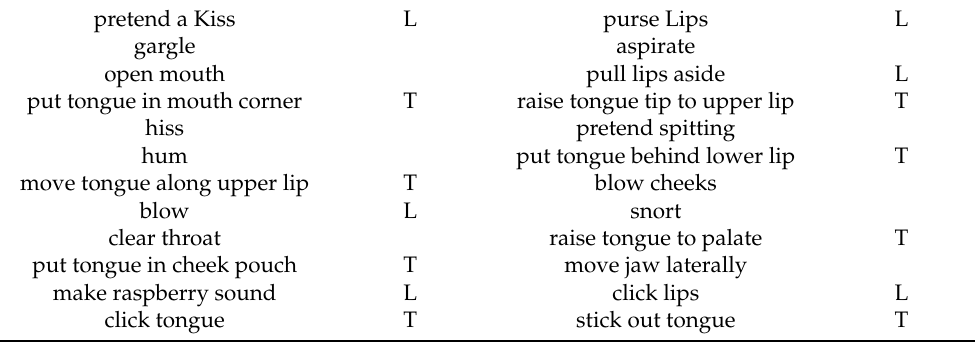
Table A6. Verbal instructions for single nonspeech oral motor actions (parameter SNGL) . Each task was instructed verbally and modeled by the examiner. Tasks selected for the effector-specific analysis are marked by L (lips, n = 5) and T (tongue, n = 8).